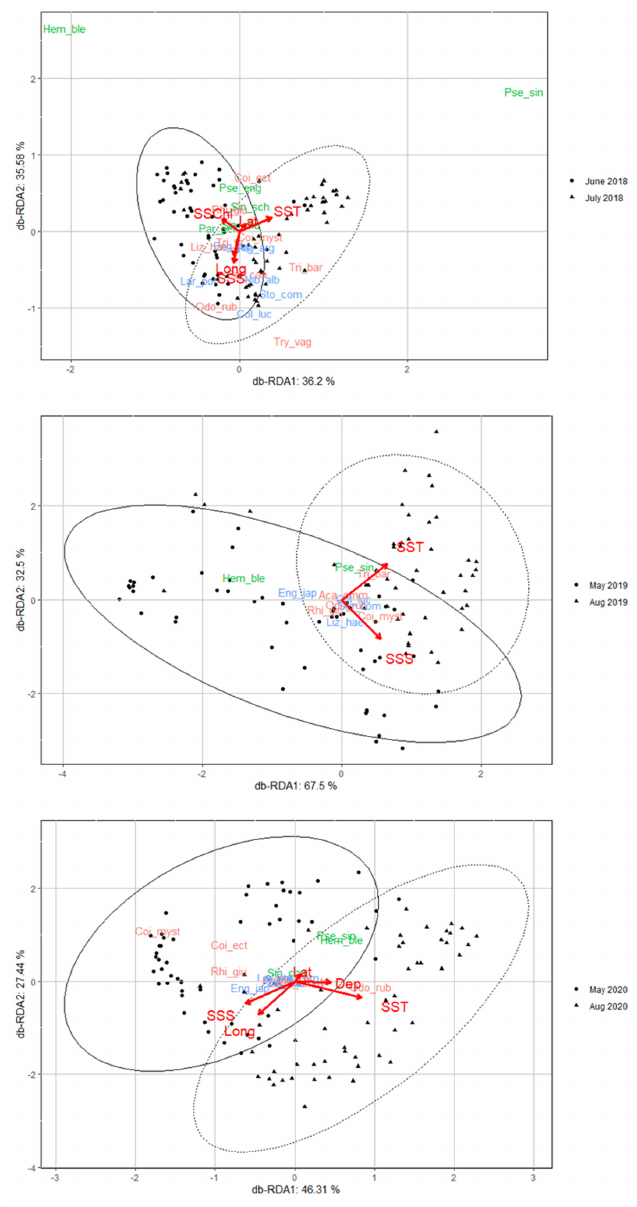
Figure 8. Ordination plot resulting from distance-based redundancy analysis (db-RDA) for the larval fish community using Bray − Curtis distance, examining the relationship between the sampling sites (points), the significant environmental variables (red arrows, p < 0.05), and species abundance (colored font: green for freshwater species, pink for brackish water species, and blue for marine species, only species with occurrence >5%). Environmental variables were latitude (Lat), longitude (Long), sea surface temperature (SST, ◦ C), depth (Dep, m), sea surface salinity (SSS), and sea surface chlorophyll a (SSchl, mg/m 3